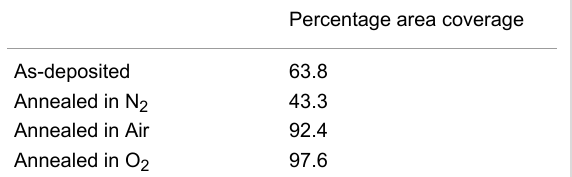
Table 1: Area coverage for samples annealed under different ambient conditions.